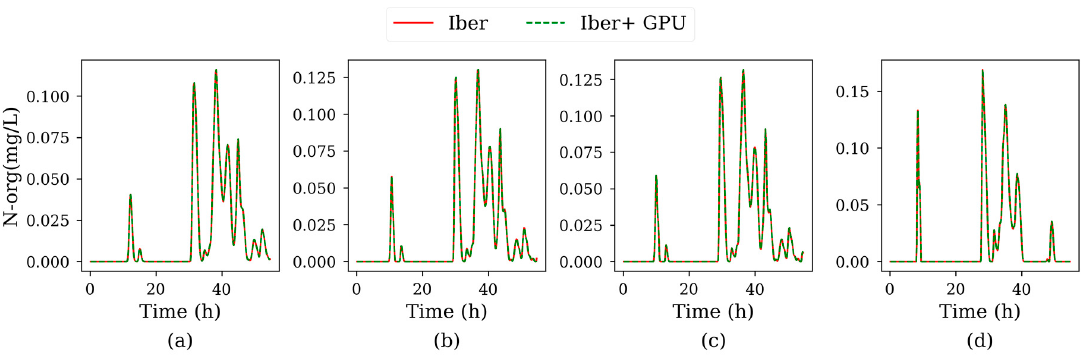
Figure A2. Time series of CBOD for Test 3, sampled at control points P1 ( a ), P2 ( b ), P3 ( c ) and P4 ( d ).